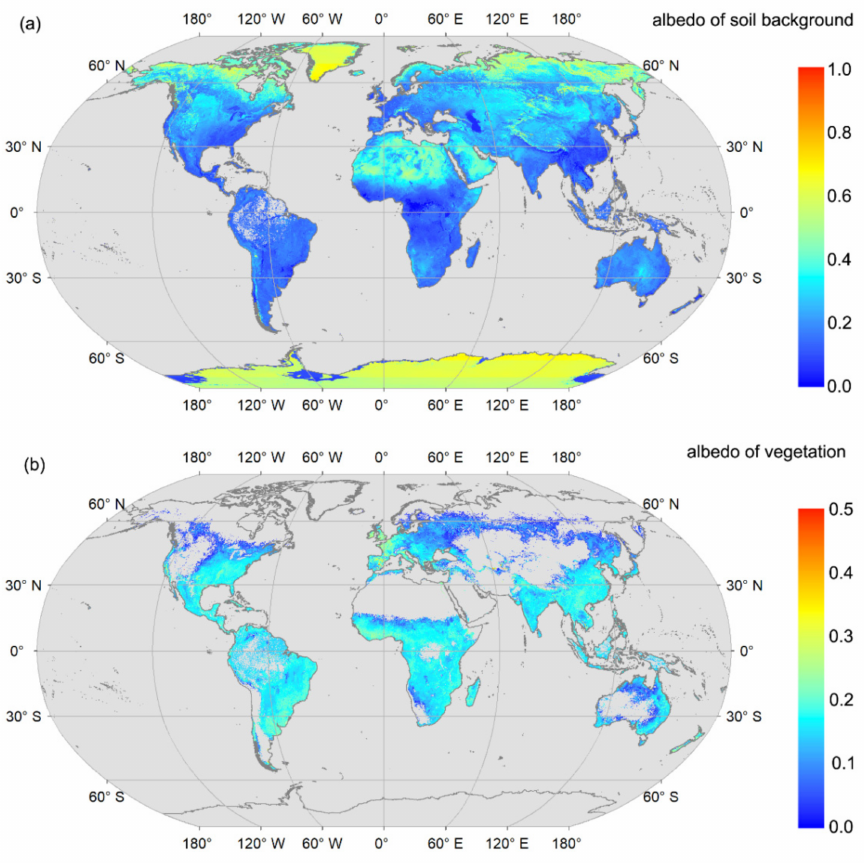
Figure 6. Spatial distribution of the albedo values of the soil background and vegetation. ( a ) Albedo values of the soil background and ( b ) Albedo values of the vegetation. The pixels with no data are colored grey.